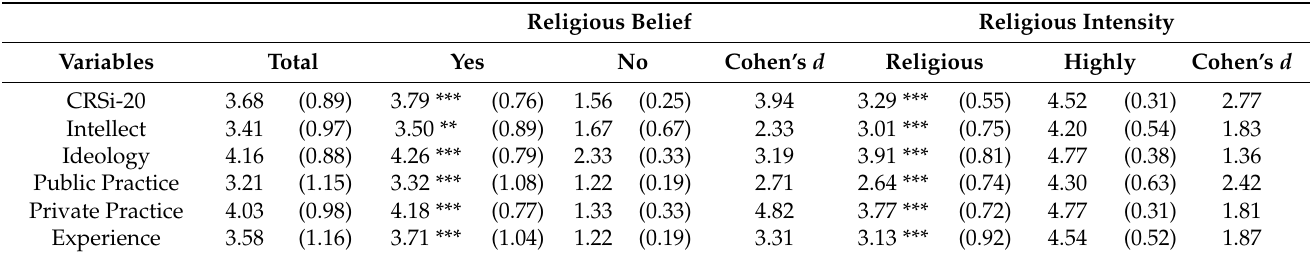
Table 4. Comparison of the religious and non-religious